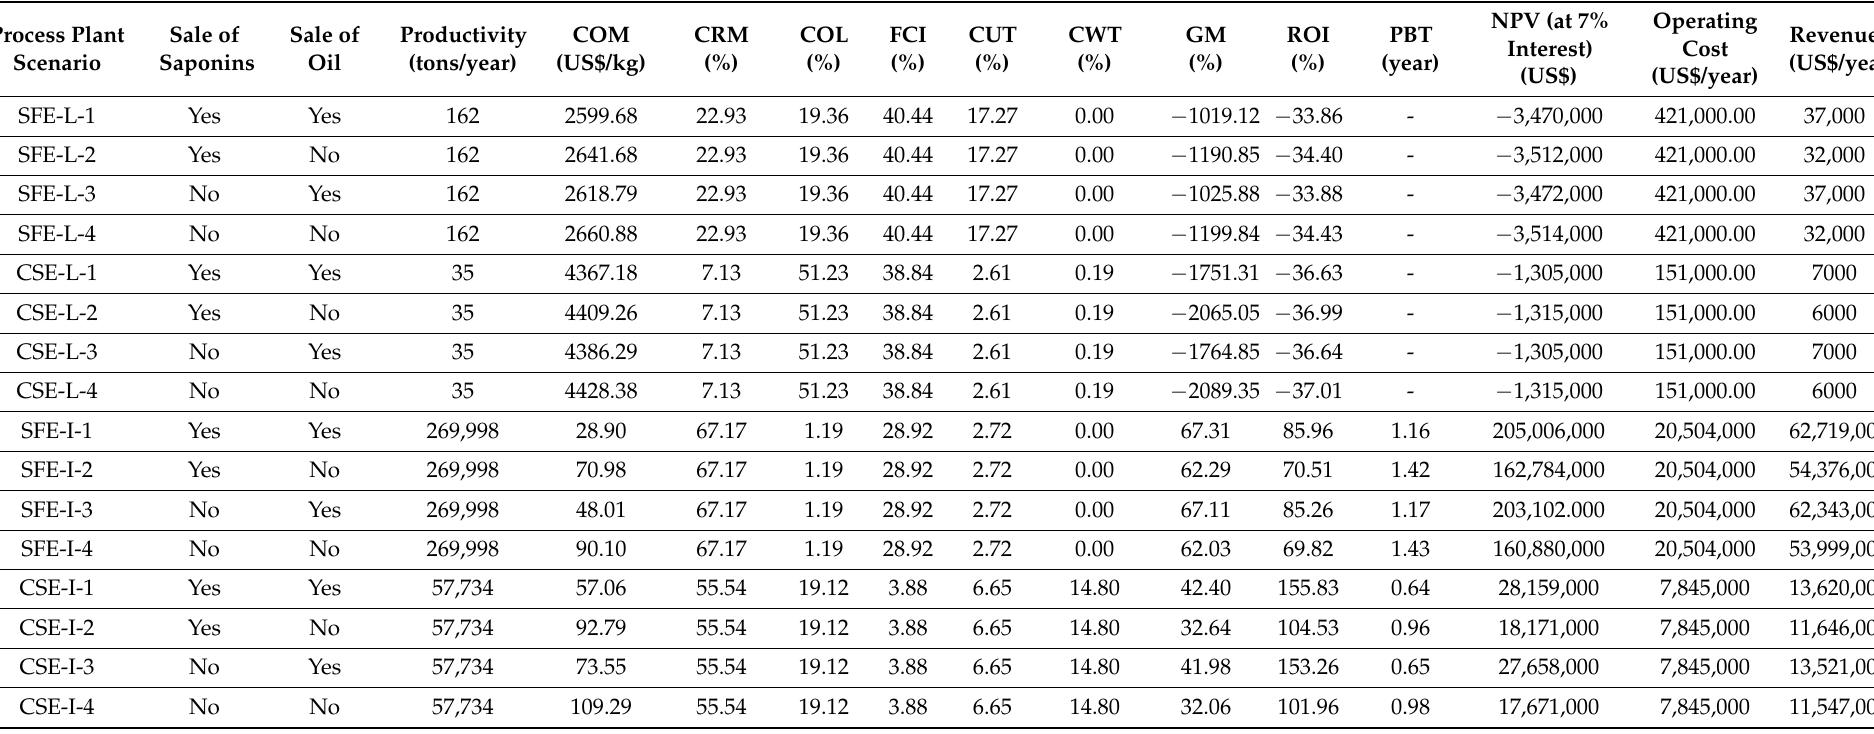
Table 5. Cost of manufacturing of quinoa protein hydrolysate (QPH) for both scales (laboratory = 1.5 kg/batch and industrial = 2500